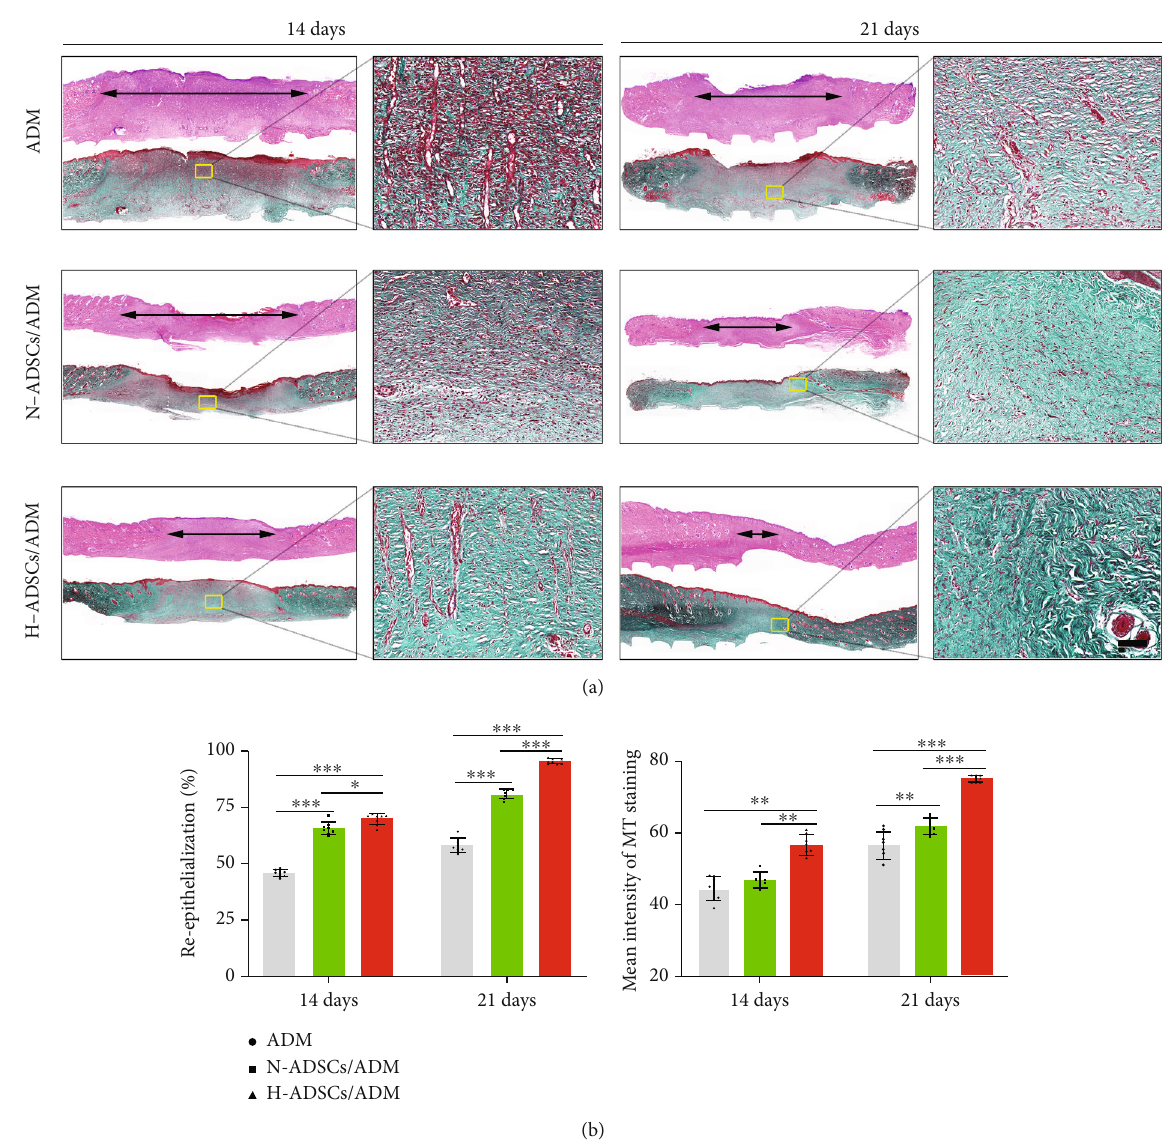
Figure 8: H-ADSCs/ADM facilitating reepithelialization and collagen deposition in diabetic wounds. (a) The images of H&E- and MT- stained sections in the ADM, N-ADSCs/ADM, and H-ADSCs/ADM groups at 14 or 21 days after the operation. “ Double-headed black arrows ” mean the edges of the scars. Bar = 100 μ m. (b) Quantitative analysis of the reepithelialization extent and the mean intensity of MT staining in the histological sections of the ADM, N-ADSCs/ADM, and H-ADSCs/ADM groups, n = 8 per group. All data are shown as means ± standard deviation ( ∗ P < 0 : 05 , ∗∗ P < 0 : 01 , and ∗∗∗ P < 0 : 001